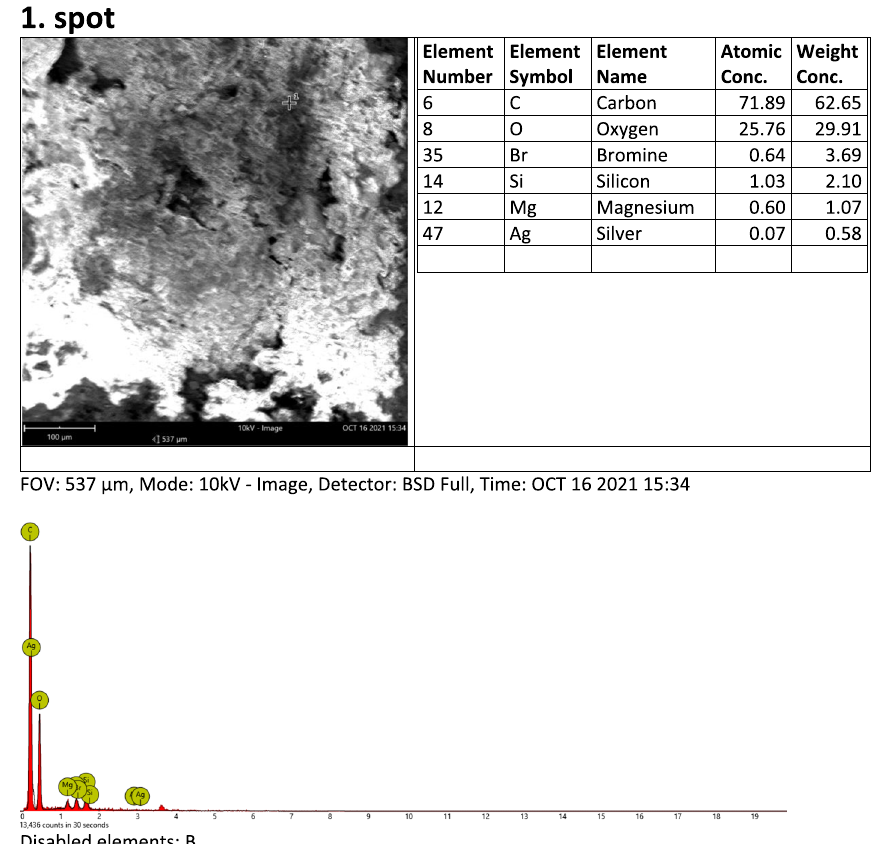
Fig. 5 Image 1 SEM-EDX for the friction lining material (FOV, 537 μm; mode, 10 kV—image, detector: BSD